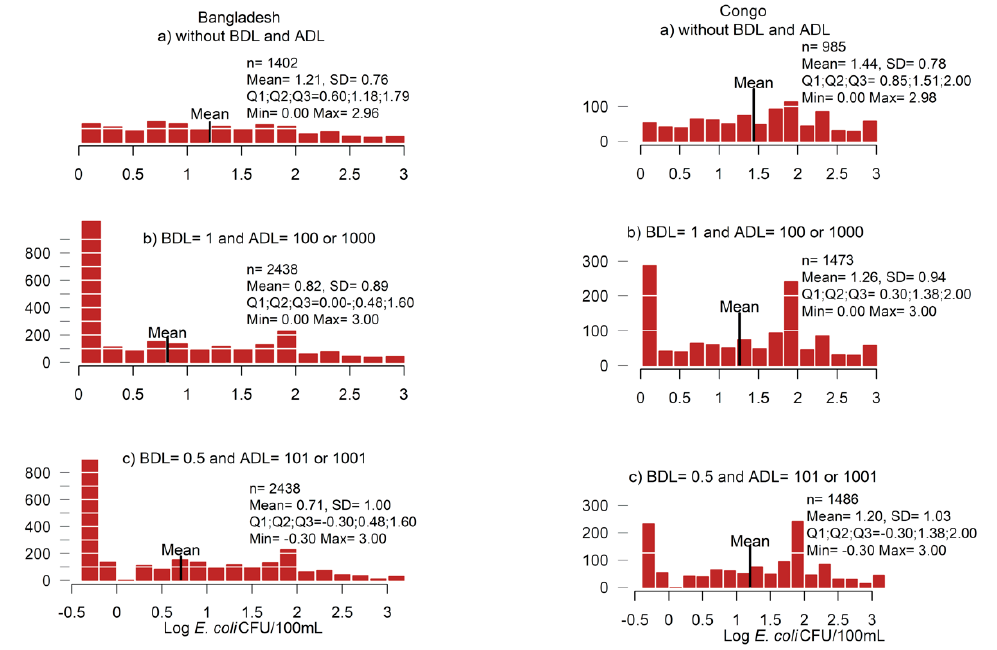
Figure 3. Characterization of Escherichia coli data from Bangladesh ( left column ) and Congo ( right column ) household water samples applying three BDL and ADL replacement methods: ( a ) excluding ADL and BDL data; ( b ) replacing BDL = 1 and ADL = 100 or 1000 depending on the sample volume; ( c ) replacing BDL = 0.5 and ADL = 101 or 1001 depending on sample value.